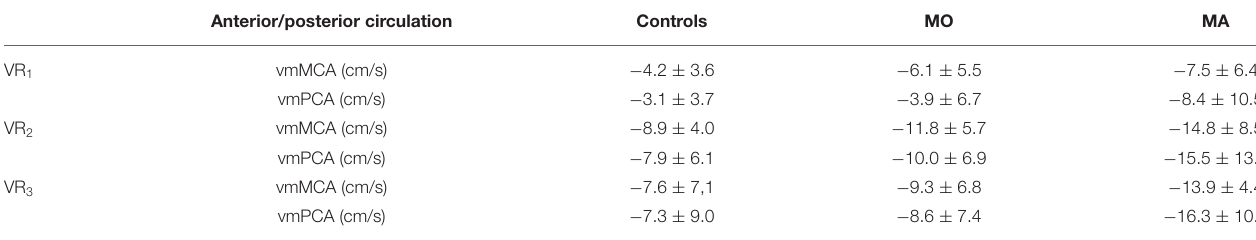
TABLE 1 | The VR MCA and VR PCA for MO, MA and control group. Anterior/posterior